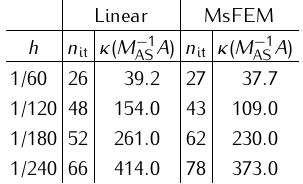
Table 7. Iteration numbers n and condition numbers κ ( M − 1 A ) for Experiment 4; geometry: 1 /h× 1 /h×H/h ; H = 12 h ; linear and multiscale it AS coarsening for different h ; contrast: E c = 10